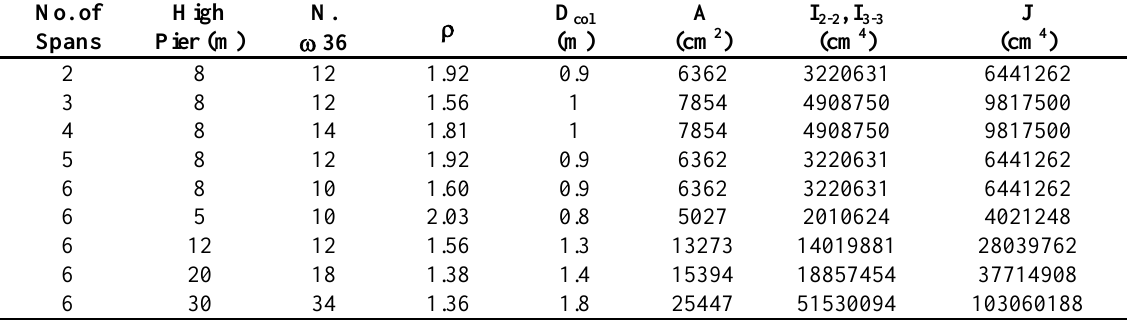
Table 2. The specifications of bridge pier cross sections (Jahanfekr, 2011). No. of High Spans Pier (m)